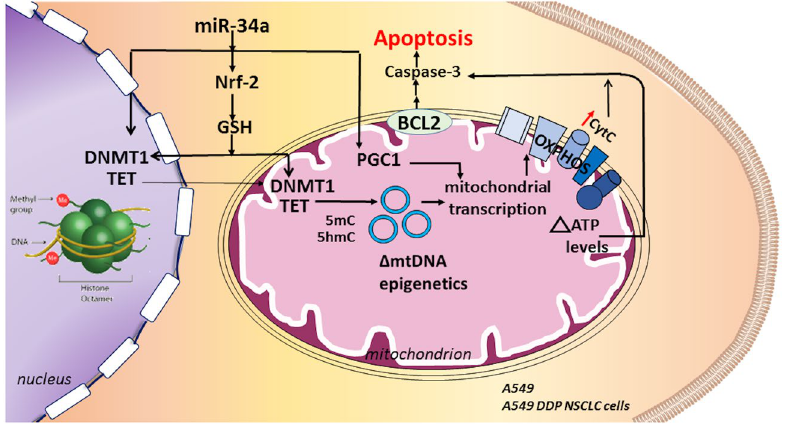
Figure 8. Summary Effect of miR34a. The miR34a delivery using HA-NPs can induce apoptosis in cisplatin sensitive (A549) and cisplatin resistant (A549 DDP) NSCLC cancer cell lines. miR34a can inhibit the Nrf-2 pathway and result in decreased levels of Glutathione (GSH). This altered redox status can further affect the levels of DNA methyl transferase (DNMT1) as well as Ten Eleven Translocase (TET) enzymes. Such altered levels of epigenetic enzymes can further lead to altered epigenetic status on mitochondrial DNA (mtDNA) and resulting in altered mitochondrial transcription and mitochondrial bioenergetics. Consequently, elevated mitochondrial ATP and cytochrome C oxidase can further contribute towards caspase activation and apoptotic induction. This process is also supported by the effects of PGC1-alpha on mitochondrial transcription and biogenesis. In parallel, miR34a can also inhibit the anti-apoptotic factor resulting in elevated levels of caspase-3 activation and apoptotic